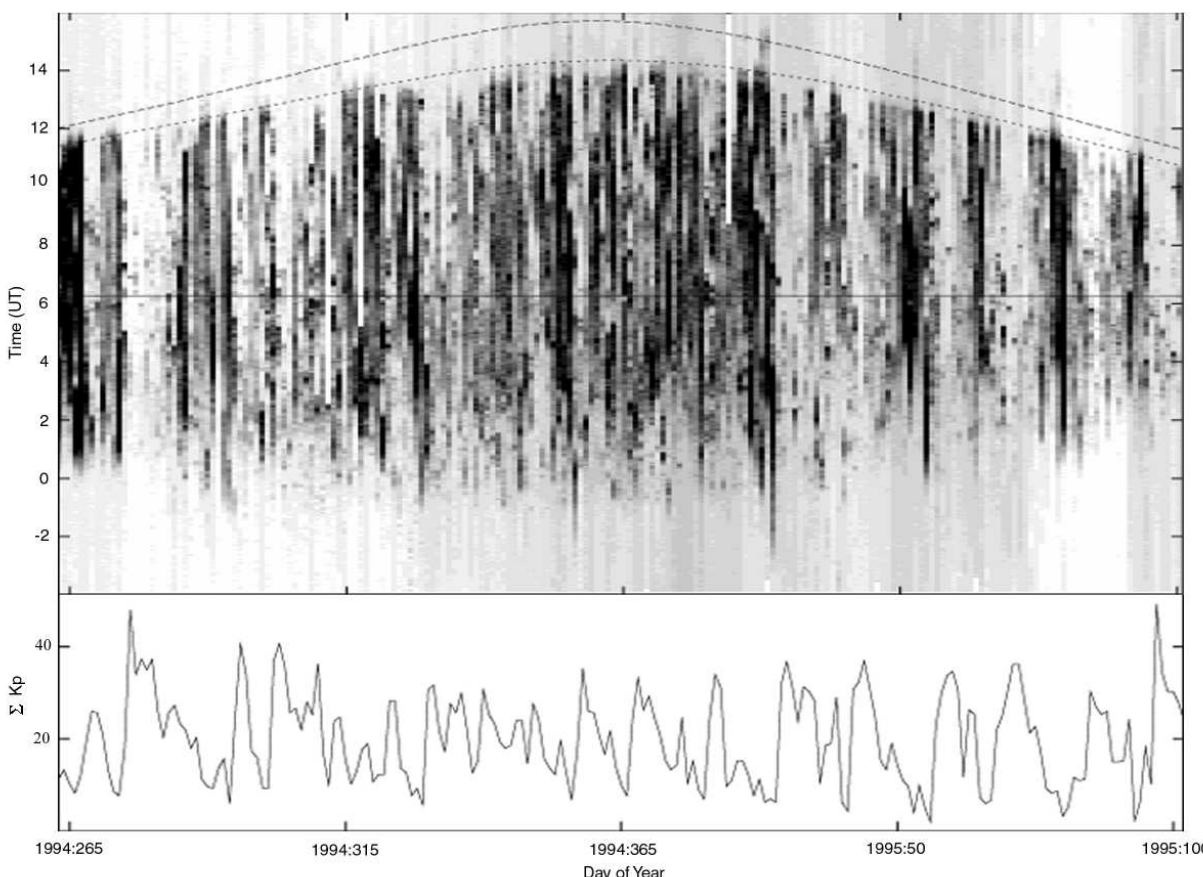
Fig. 3. Six months of radio propagation data recorded at Arviat, Nunavut. The horizontal axis is day of year starting on day 263 of 1994 and ending on day 102 of 1995. The vertical axis represents 20:00–16:00UT; geographic local midnight corresponds to 06:16 UT, near the center of the plot. The received radio frequency power integrated over the frequency range 550–1600kHz, corresponding to the AM broadcast band, is encoded in the gray scale, with white (black) pixels corresponding to integrated rms amplitudes below 0.3mV/m (above 4mV/m). The upper long-dashed line represents the time of sunrise at ground-level at Arviat, and the lower short-dashed line represents the time of sunrise 250km south of Arviat at an altitude of 80km, using grazing incidence at 55km to define sunrise. The lower panel displays daily sum Kp index smoothed with a 7-day running